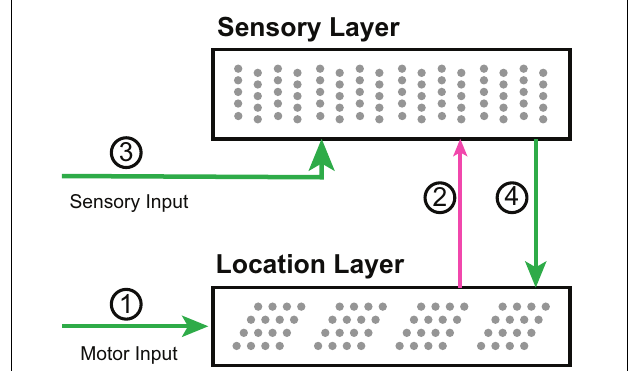
FIGURE 3 | A diagram of the network with arrows indicating the main connections. (1) Motor input shifts the activity in the location layer, which consists of a set of independent grid cell modules. (2) The active location cells provide modulatory predictive input to the sensory layer. (3) Sensory input activates cells in the sensory layer. (4) The location is updated by the new sensory